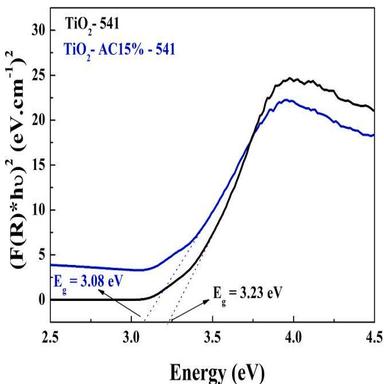
Plot of (F (R) hν) 2 x Energy for the band gap (Eg) calculation of the samples TiO2-541, TiO2-AC15%-541.